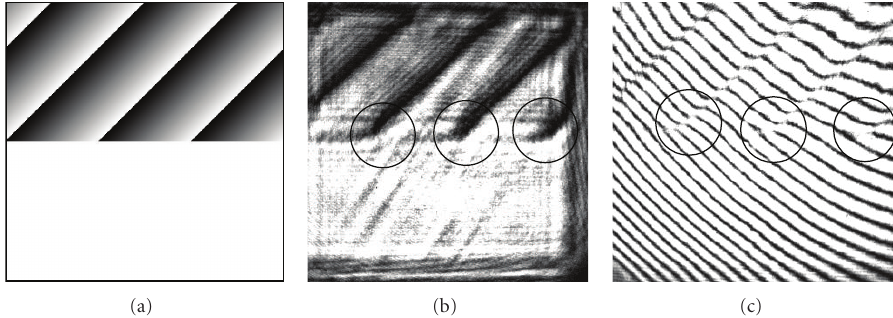
Figure 5: (a) Phase distribution for linear array of inclined phase ramps with constant background. (b) Experimentally observed intensity distribution of propagated field when phase mask corresponding to (a) is displayed onto the SLM. (c) Formation of fork fringes when the propagated field interfers with a plane wave coming from the other arm of the Mach-Zehnder interferometer.